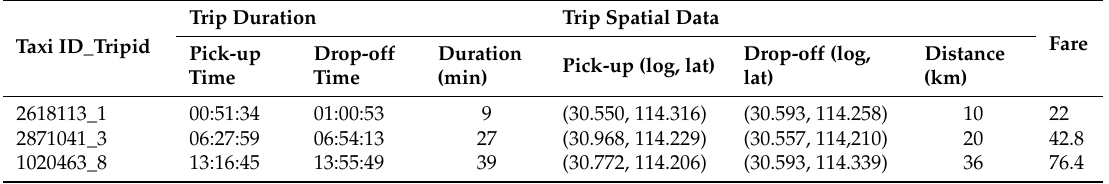
Table 4. Examples of occupied trips’